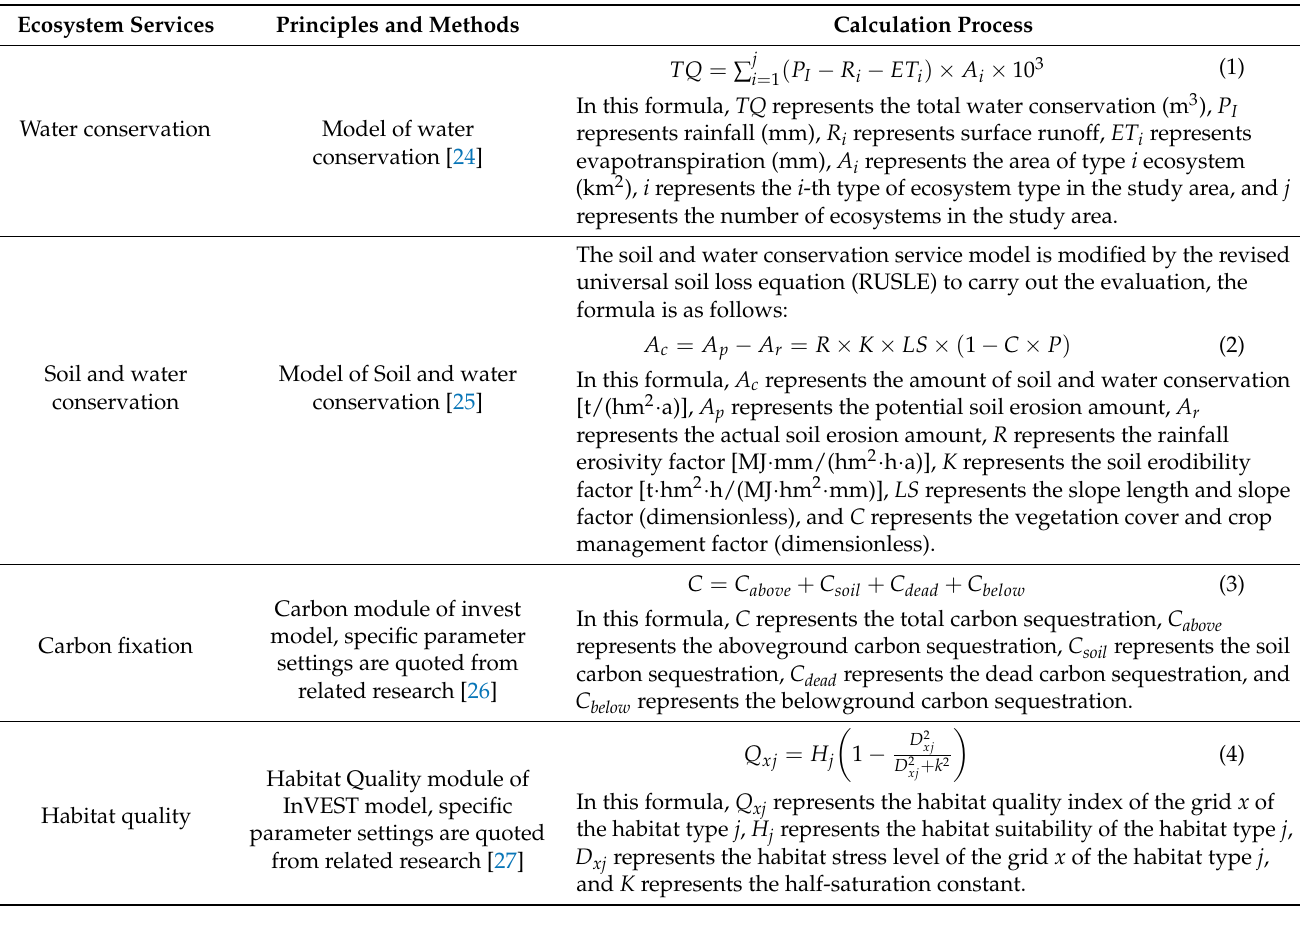
Table 2. Ecosystem service assessment method and calculation